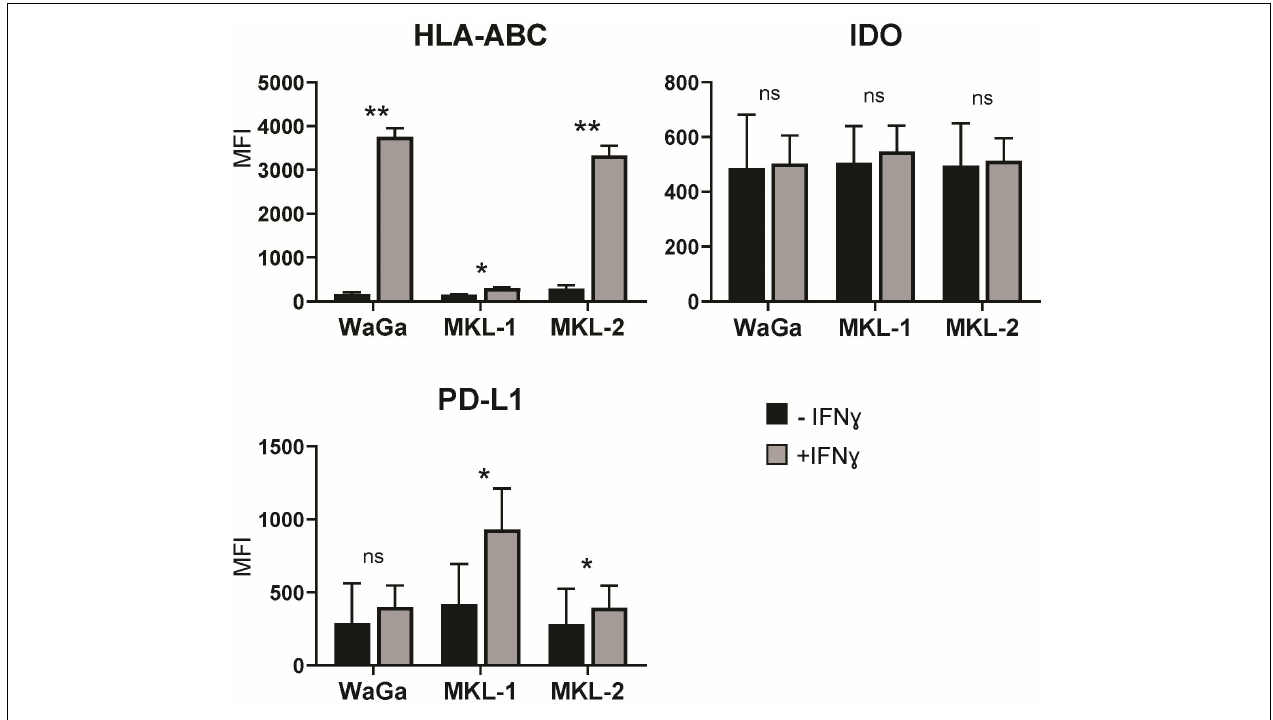
FIGURE 1 | Merkel cell carcinoma cell lines respond to IFN γ by upregulating different proteins. After 72 h of treatment with or without IFN γ (3,000 U/ml), the Merkel cell carcinoma cell lines MKL-1, MKL-2, and WaGa were stained for human leukocyte antigen A, B, and C (HLA-ABC), indoleamine-2,3-dioxygenase (IDO), and programmed cell death 1 ligand 1 (PD-L1) and analyzed by flow cytometry. The average mean fluorescent intensity (MFI) of three to four independent experiments ± standard error is indicated. p -values were determined using the paired student’s t -test. * p < 0.05; ** p < 0.01; ns, not